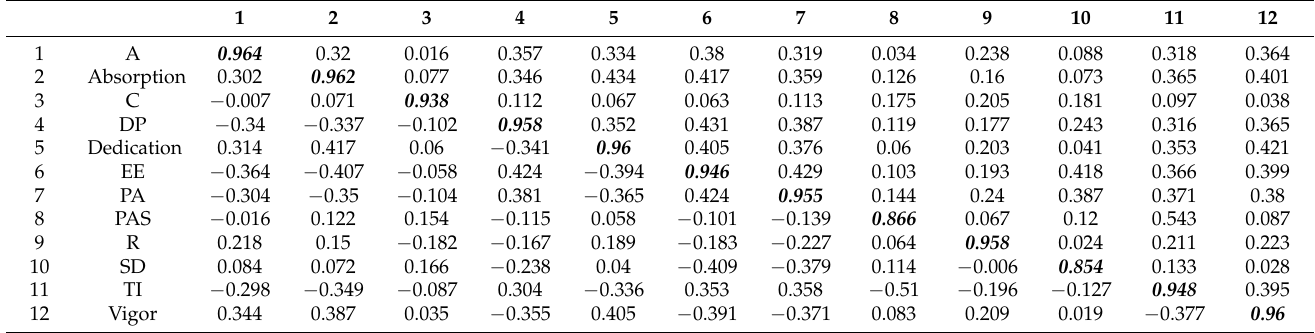
Table A5. Stage 1—Discriminant Validity according to HTMT Values and the Fornell–Larcker Criterion.